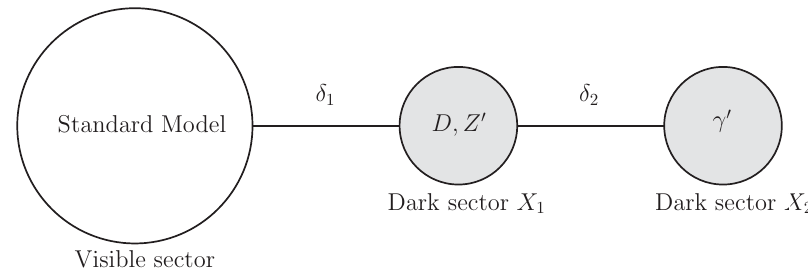
Figure 1 . The exhibition of the model we consider in the paper. The standard model has a direct coupling with hidden sector X 1 with strength proportional to δ 1 , whereas hidden sector X 2 only interacts directly with X 1 with strength proportional to δ 2 , and thus X 2 interacts with the standard model only